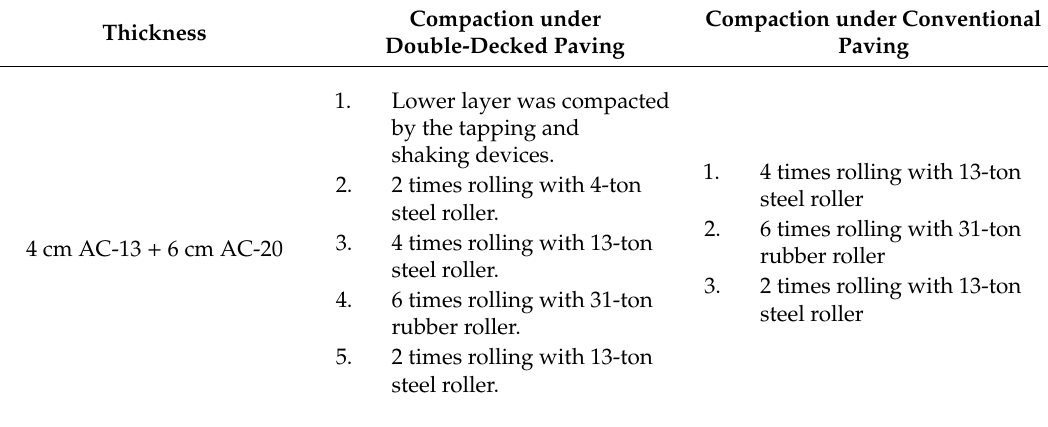
Layer thickness and compaction method under conventional and double-decked paving